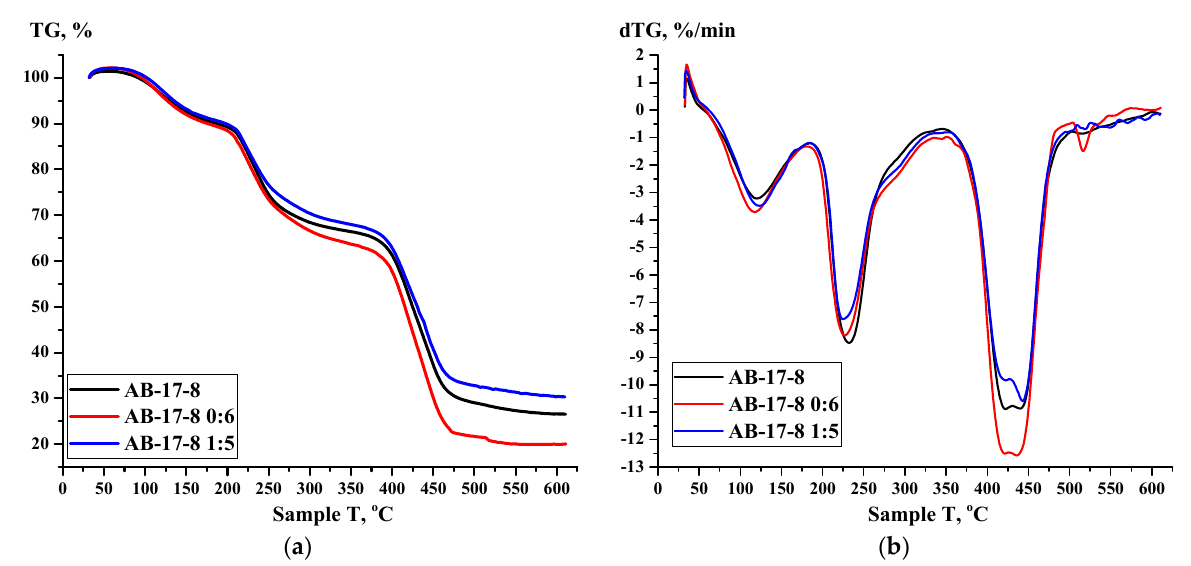
Figure 15. TGA curves of ( a ) mass loss and ( b ) rate of mass loss of AB-17-8. 3.4. Growth of the Sorption Properties in Interpolymer Pair Amberlite IR120:AB-17-8 = 1:5 Growth of extraction degree of europium ions relative to the initial ion exchangers Amberlite IR120 and AB-17-8 is presented on Figure 16. The highest increase occurs during 2.5 h of remote interaction. Interpolymer pair Amberlite IR120:AB-17-8 = 1:5 has a growth of sorption degree of 707.50% at 1.5 h of interaction compared with Amberlite IR120, while the growth is 224.68% compared with AB-17-8 at 2.5 h of interaction. After that time, ionization occurs not so intensively, at 27 h growth it is 57.52% and 67.80% compared with Amberlite IR120 and AB-17-8. At 40 h growth, it is 31.75% relative to Amberlite IR120 and 42.62 relative to Amberlite IR120.